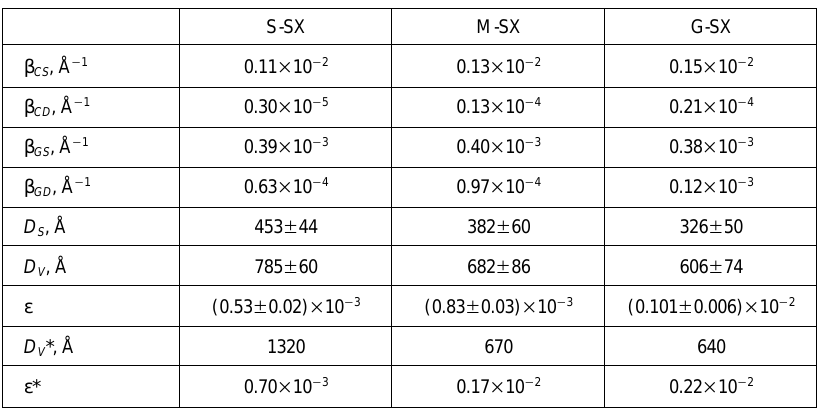
Table II The integral breaths of Voigt-approximated diffraction profile, β , and calculated values of the surface-weighted, D S , and volume-weighted, D V , domain size and the Gaussian strain, ε . The corresponding size and strain parameters, D ε * , were calculated on the basis V * and of the diffraction profile Le Bail fitting and the instrument broadening FWHM (cid:4)